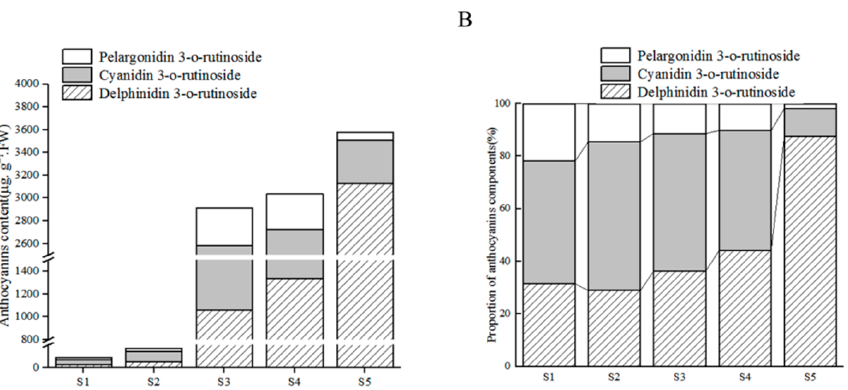
Figure 2. The accumulation of anthocyanins in petals of ‘QN’ at different development stages. ( A ) Content of three individual anthocyanin components. ( B ) Percentage of three individual anthocyanin components.